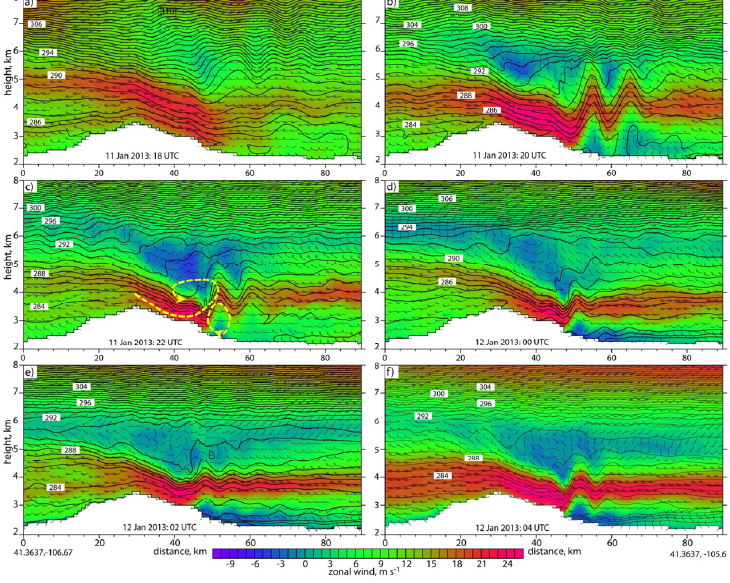
Figure 6. As in Figure 5, but showing zonal wind speed.